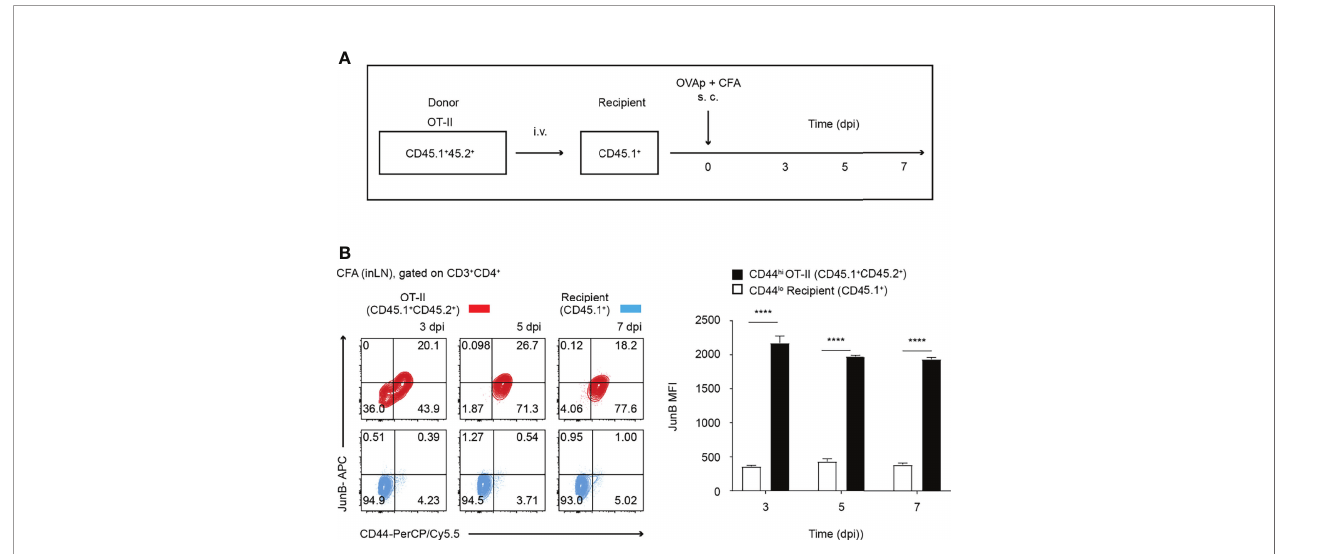
FIGURE 1 | JunB is expressed in antigen-primed CD4 + T cells in vivo . 2 x 10 6 naive OT-II cells (CD45.1 + CD45.2 + ) were transferred to congenic recipient mice (CD45.1 + ), followed by immunization with OVA 323-339 peptides emulsi fi ed in CFA. At the indicated days post-immunization (dpi), cells were harvested from inaugural lymph nodes and analyzed. (A) Immunization scheme. i.v. intravenous injection, s.c. subcutaneous injection. (B) Flow cytometry analysis of JunB expression in transferred OT-II cells (CD3 + CD4 + CD45.1 + CD45.2 + , shown in red) and recipient naïve CD4 + T cells (CD3 + CD4 + CD45.1 + , shown in blue) at the indicated dpi. Bar graphs show median fl uorescence intensity (MFI) of JunB expression levels in CD44 hi OT-II cells and CD44 lo recipient cells. Error bars indicate s.d. (n =3). **** p < 0.0001, (unpaired two-tailed Student ’ s